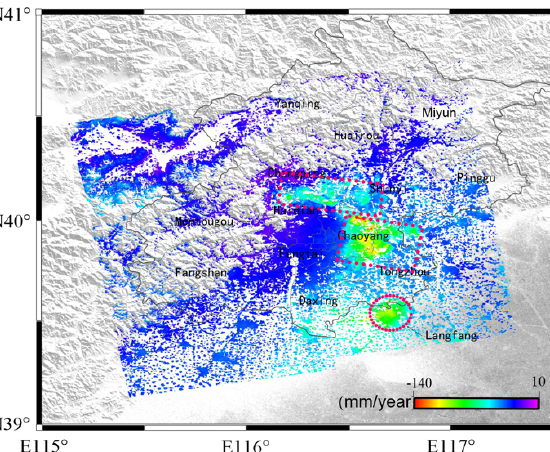
Figure 8. The mean velocity field of crustal deformation along the line of sight (LOS) direction from 2015-2017 derived from Sentinel TOPS mode SAR